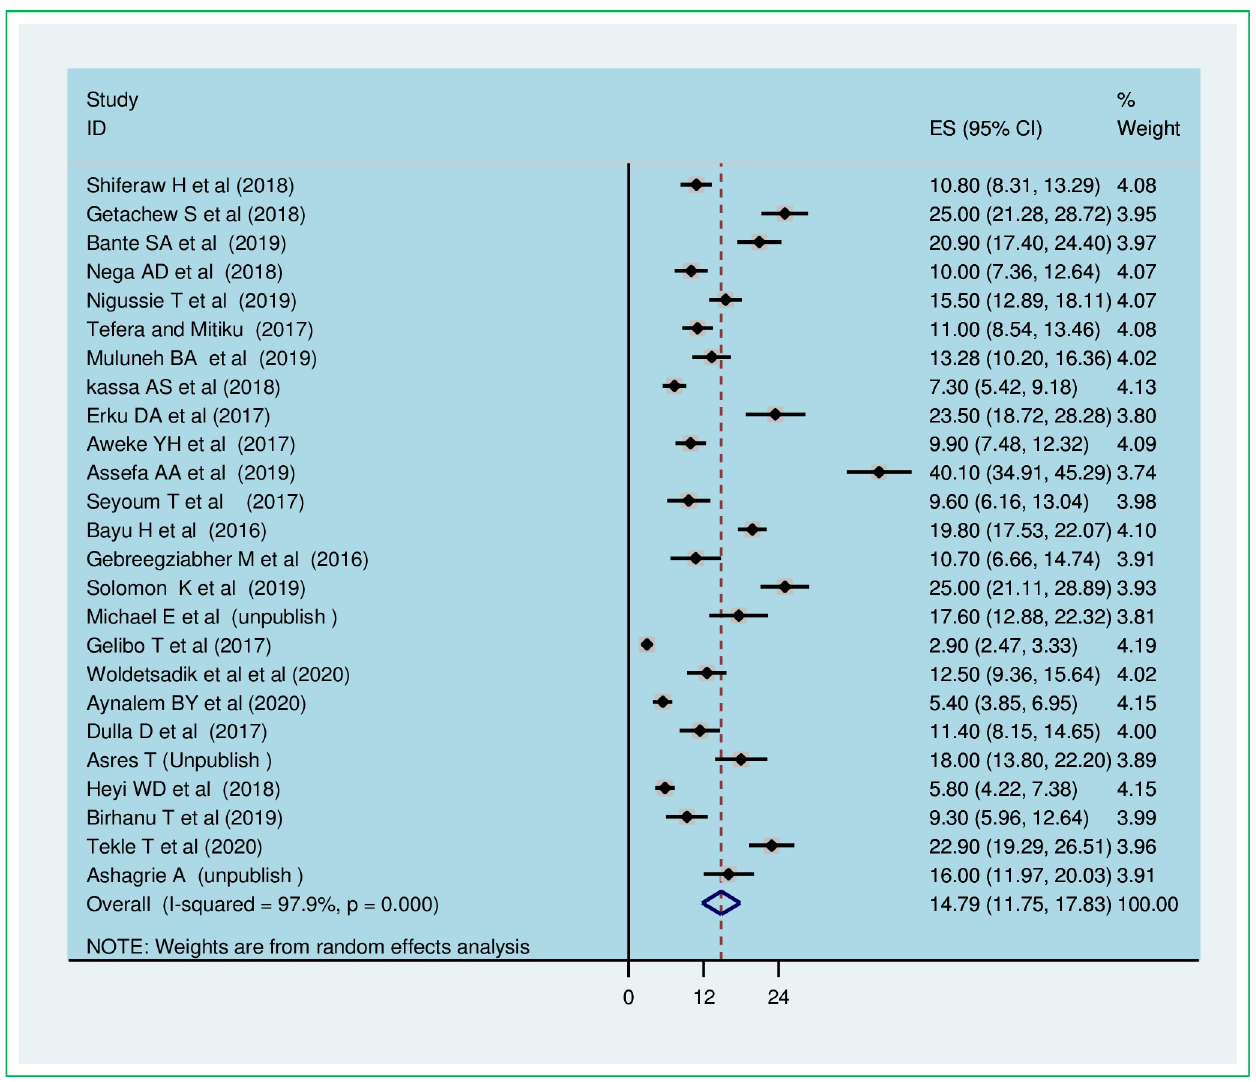
Fig 2. The pooled utilization of cervical cancer screening among women in